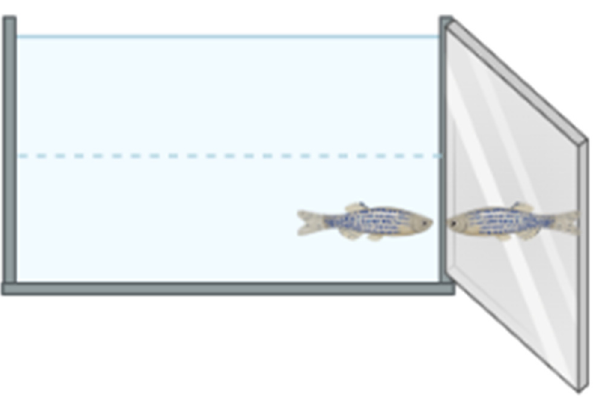
Figure 13. Mirror attack test in zebrafish. Zebrafish attack their own image, and aggressive behaviour is observed in ADHD individuals. Created with Biorender.com.